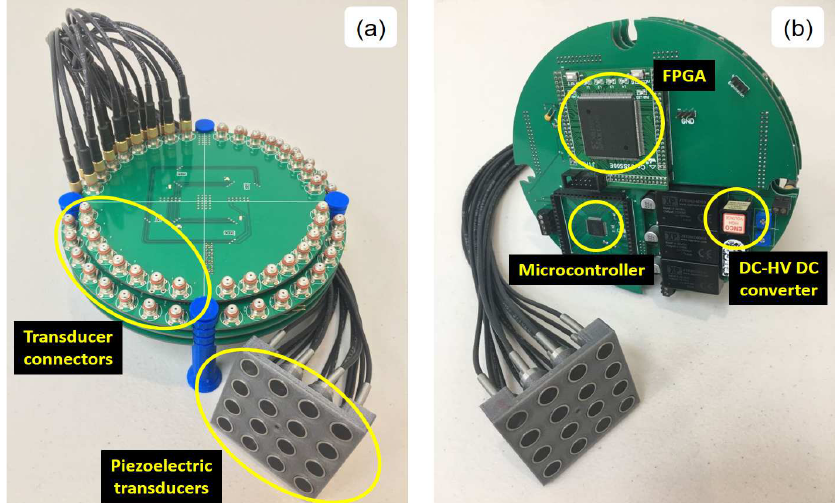
Figure 18. Ultrasound system designed for automatic pipeline inspection. ( a ) Top view and ( b ) bottom